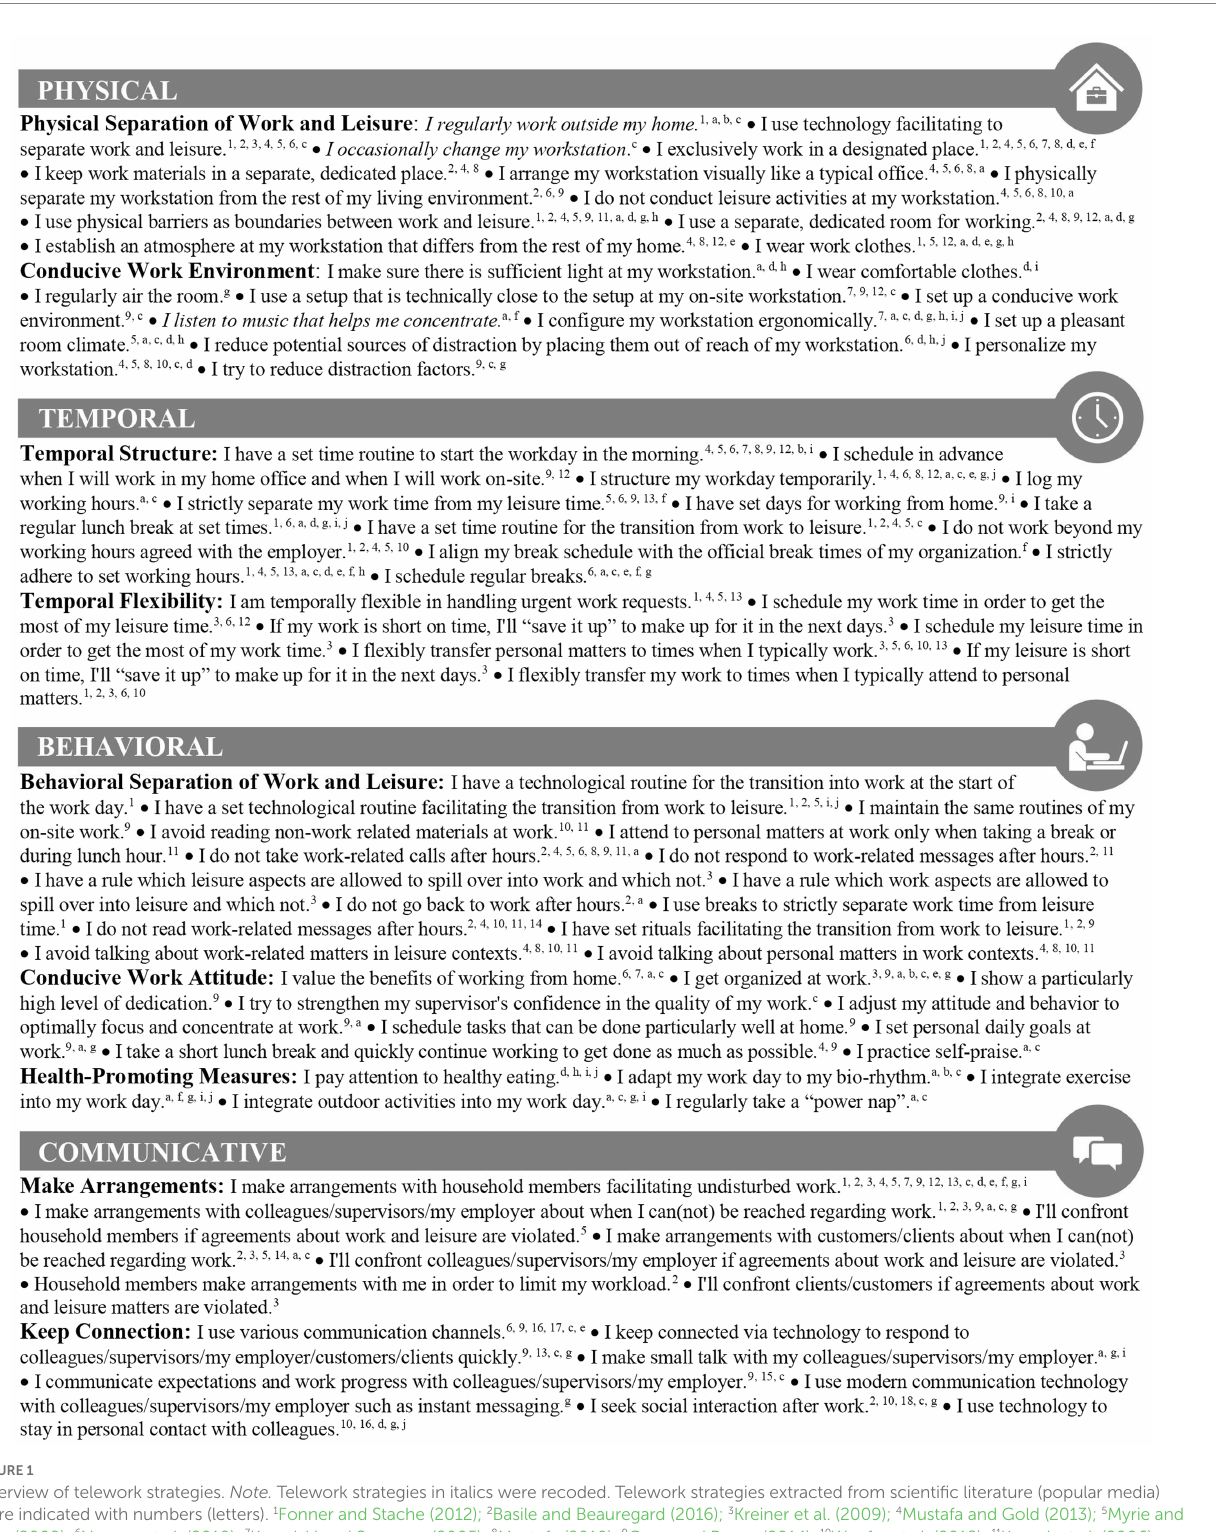
FIGURE 1 Overview of telework strategies. Note. Telework strategies in italics were recoded. Telework strategies extracted from scientific literature (popular media) were indicated with numbers (letters). 1 Fonner and Stache (2012); 2 Basile and Beauregard (2016); 3 Kreiner et al. (2009); 4 Mustafa and Gold (2013); 5 Myrie and Daly (2009); 6 Nansen et al. (2010); 7 Kowalski and Swanson (2005); 8 Mustafa (2010); 9 Greer and Payne (2014); 10 Wepfer et al. (2018); 11 Kossek et al. (2006); 12 Tietze (2002); 13 Tietze and Musson (2003); 14 Park et al. (2020); 15 Ilozor et al. (2001); 16 Golden and Raghuram (2010); 17 Turetken et al. (2011); 18 Mann et al. (2000). a Mai (n.d.); b Prophet (2017); c Schulz (2020); d Cobler (n.d.); e Stross (n.d.); f Westdeutsche Zeitung (2020); g Flatley (2020); h Vollmer (2018); i Unger (2020); j Rewe